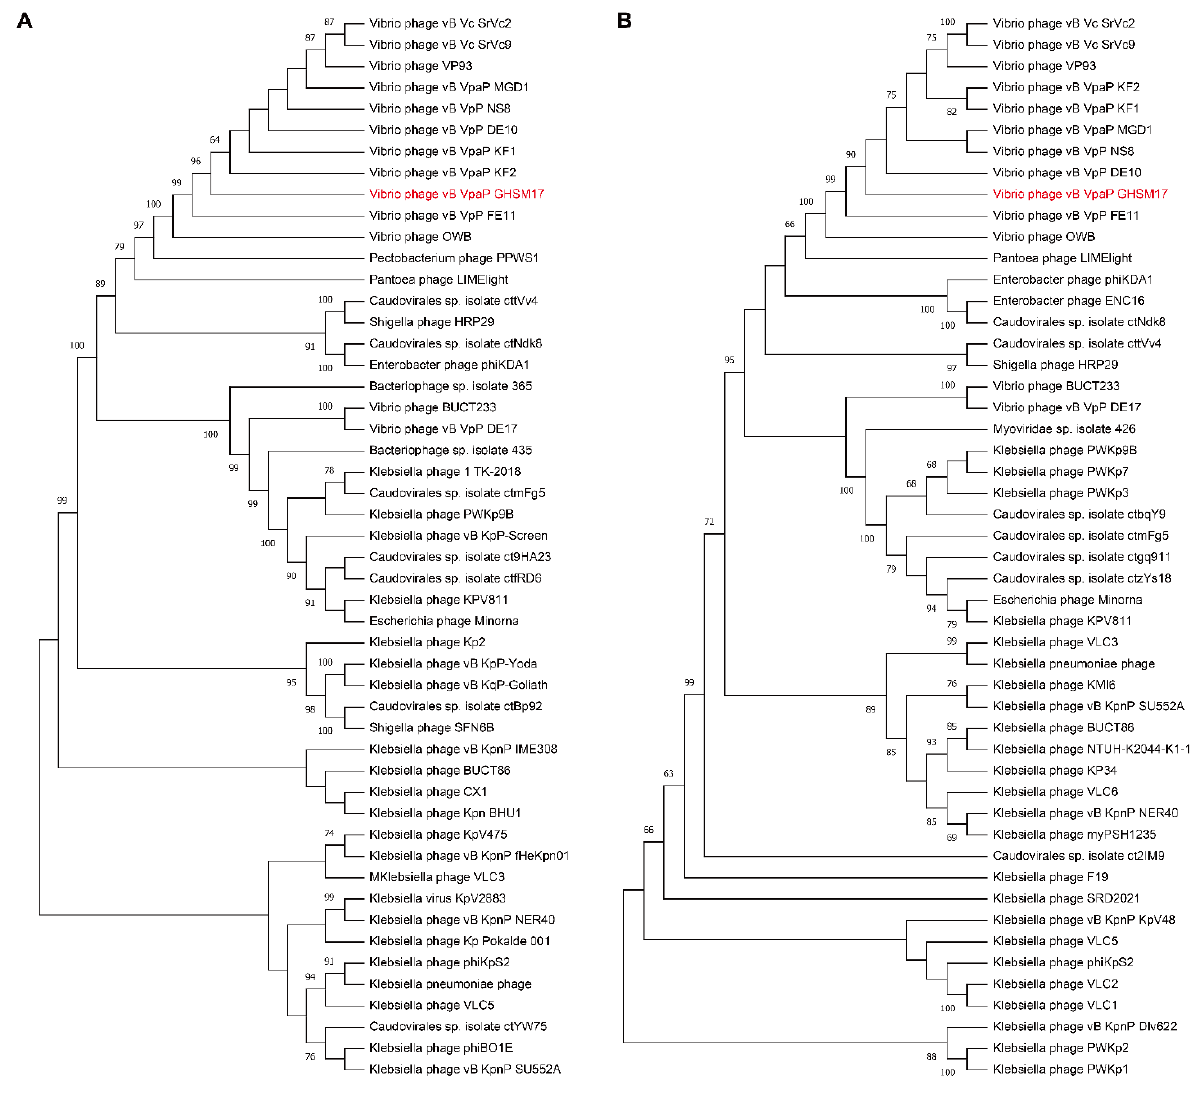
Figure 7. Phylogenetic trees of Vibrio phage from the family Autographiviridae based on ( A ) the